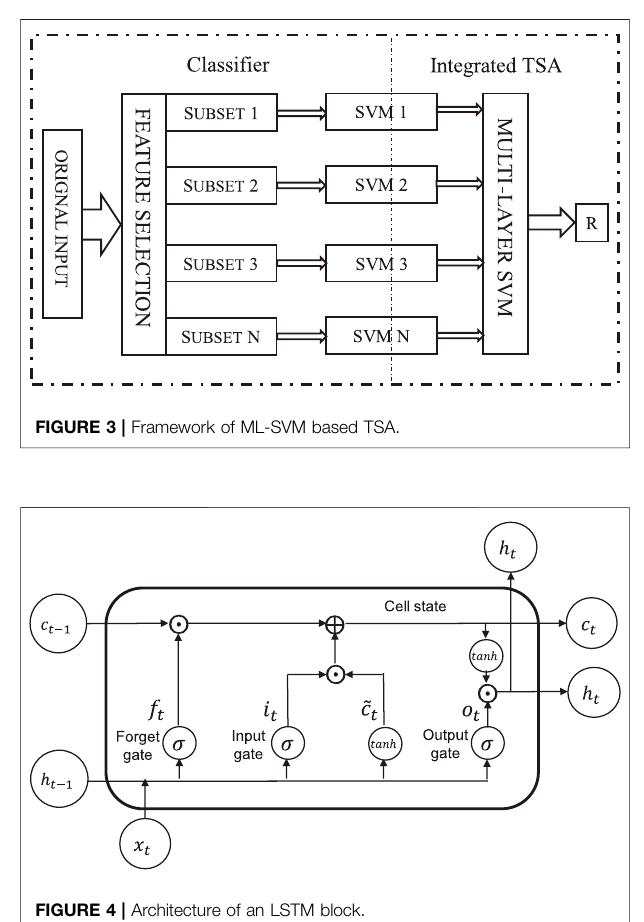
FIGURE 4 | Architecture of an LSTM block.